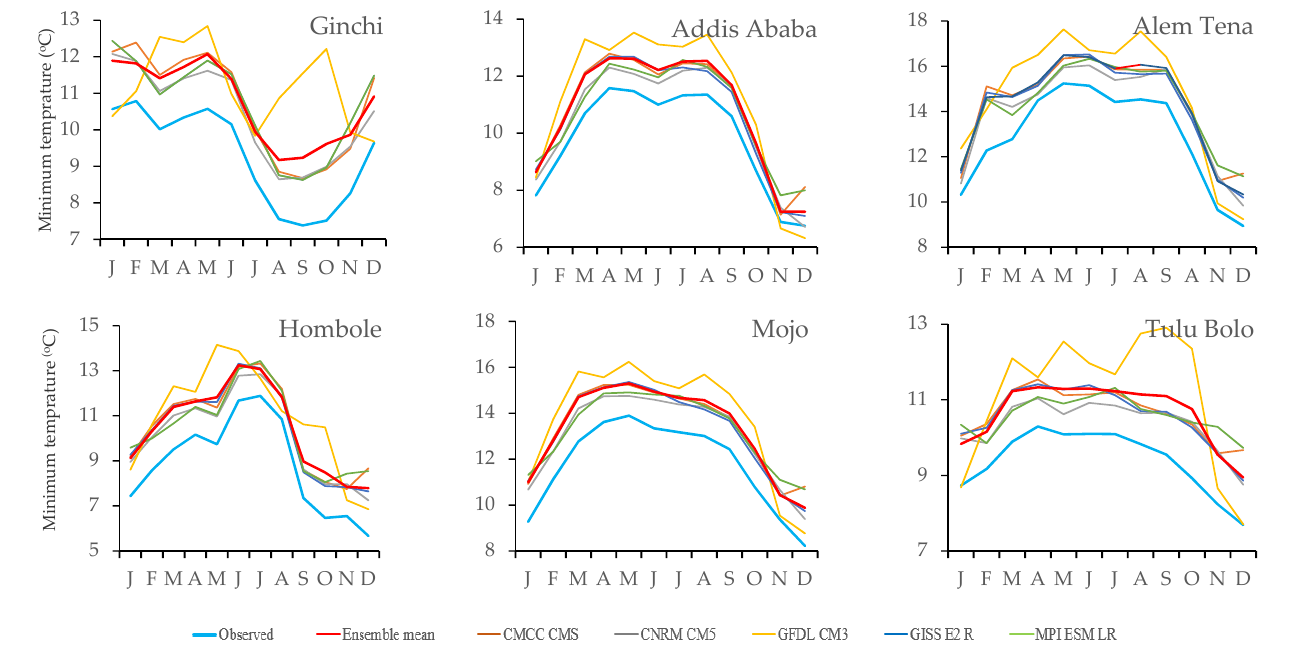
12 of 29 Figure 2. Calibration and validation result for streamflow and each gauging station for the calibra- tion and validation periods. Table 5. SWAT model calibration and validation performance. Stations